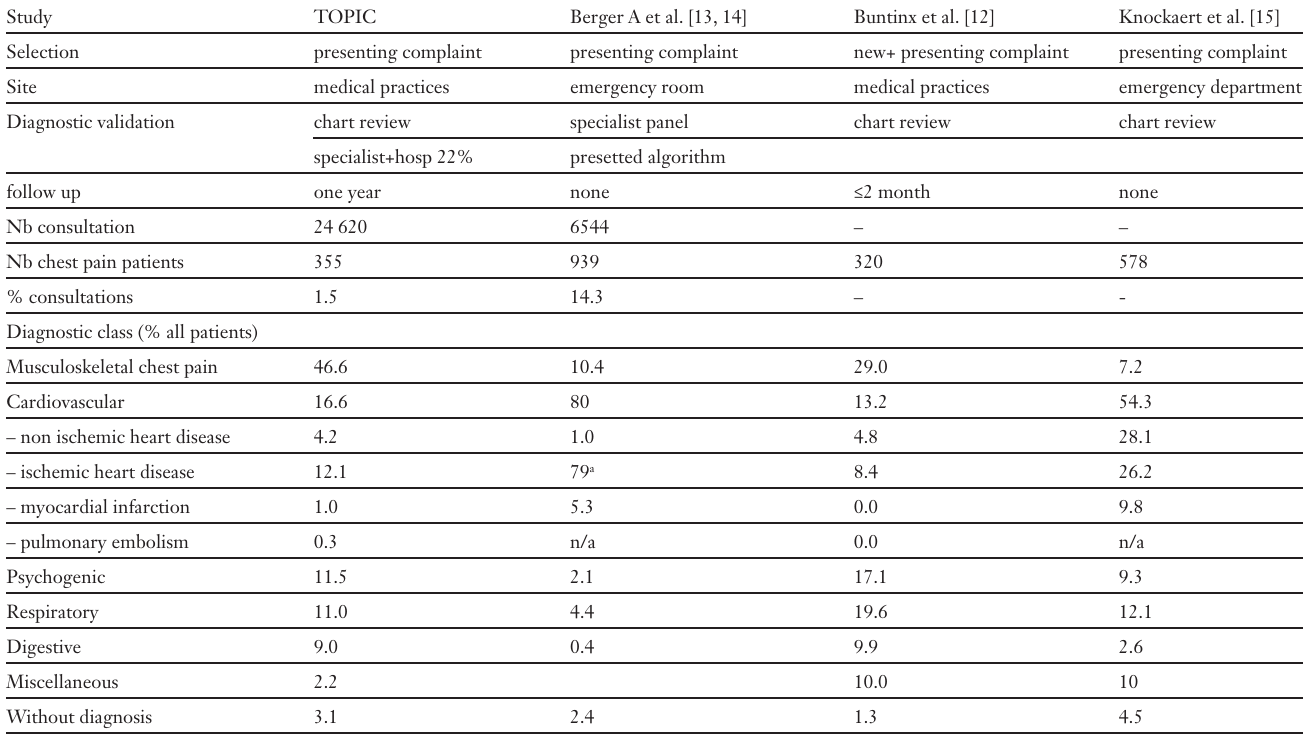
Comparison of chest pain epidemiology in two ambulatory and two related emergency